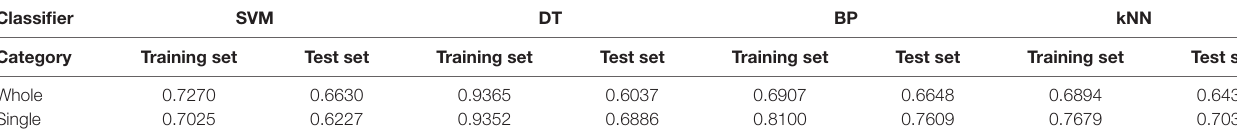
TABLE 8 | The effect of dual-channel 20-dimensional features on emotion classification.